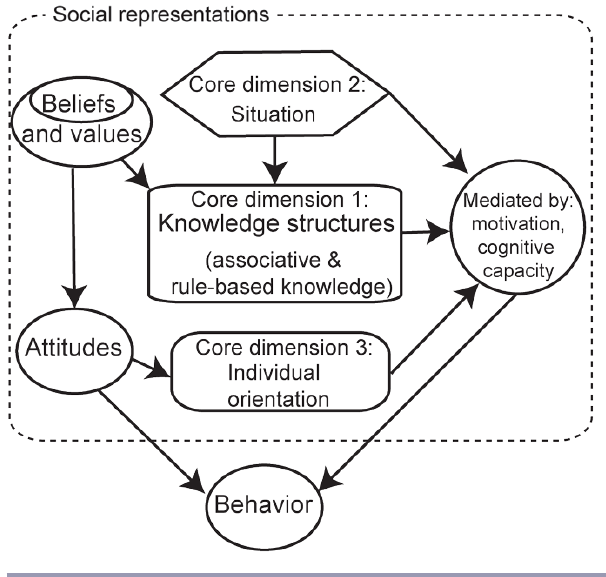
Fig. 1 . Simplified conceptual model of forest owner representation of forest management influencing